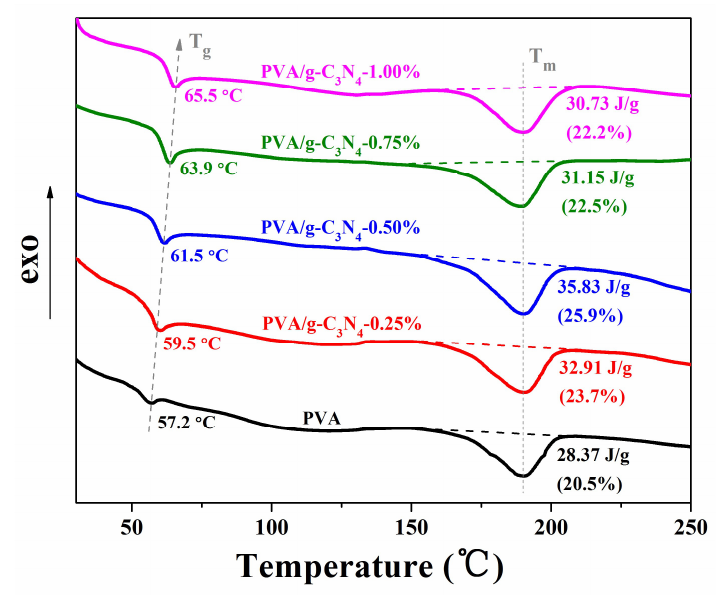
Figure 6. DSC curves of pure PVA and PVA/g-C 3 N 4 nanocomposites. Figure 6 . DSC curves of pure PVA and PVA/g-C 3 N 4 nanocomposites .